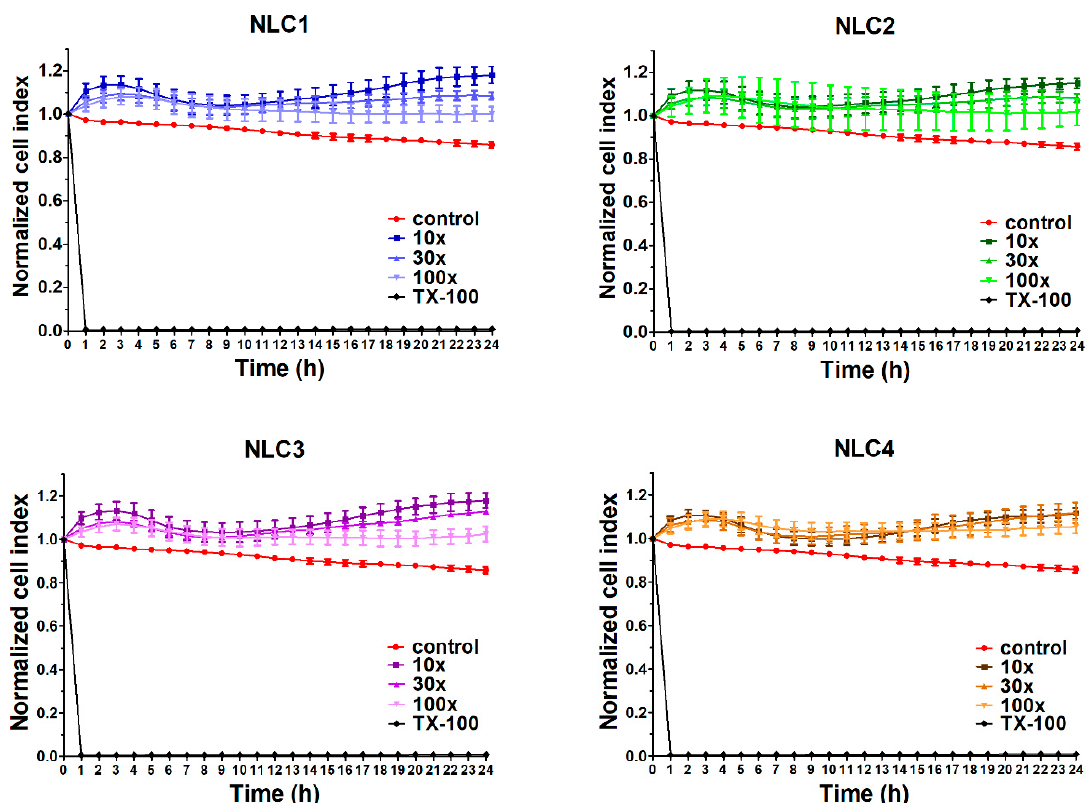
Figure 3. Cell viability of HCE-T cornea epithelial cells treated with different formulations measured by real-time electric sensing. Values are presented as means ± SD, n = 6–10. 10×: 10-times dilution; 30×: 30-times dilution; 100×: 100-times dilution; NLC, Nanostructured lipid carriers; TX-100, Triton X-100.